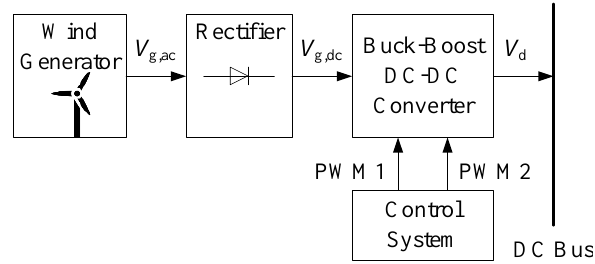
Fig. 2. Connection of the wind generator to the DC bus: V g,ac – wind generator output AC voltage; V g,dc – wind generator rectified voltage; V d – DC bus voltage; PWM1 – control signal for the buck mode; PWM2 – control signal for the boost mode.